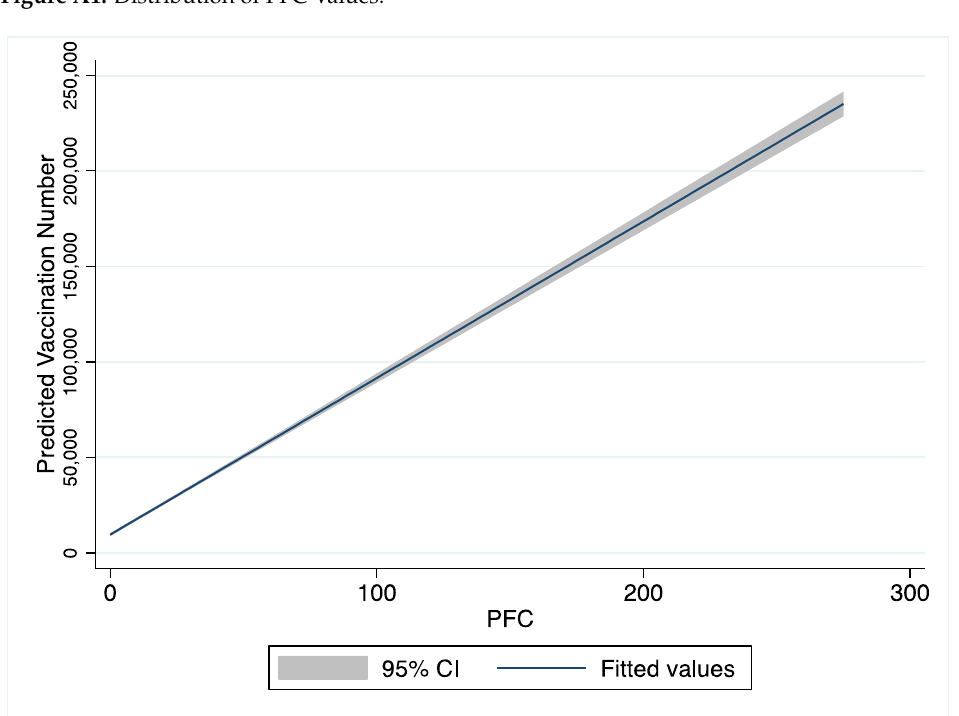
Figure A2. Trend of Predicted Vaccination Number by PFC Values.